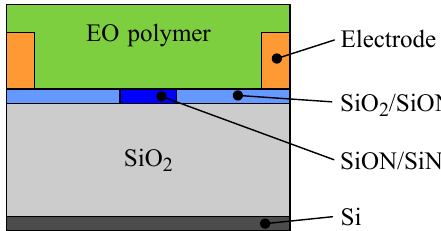
Figure 2. Optimized waveguide design, which enables a more homogenous poling field to reduce poling induced losses.